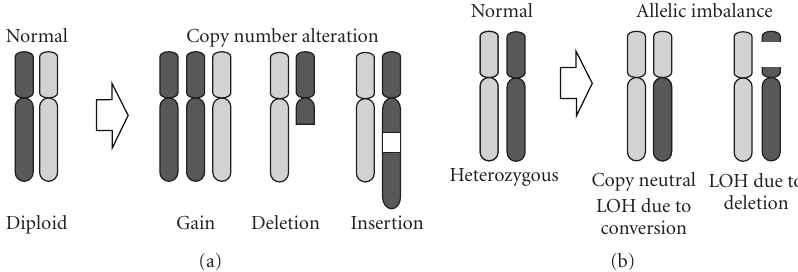
Figure 1: Mechanisms of DNA copy number alteration. (a) Segmental gains and losses can lead to DNA copy number alterations. (b) Allelic imbalance and loss of heterozygosity (LOH) can arise from a deletion event or gene conversion during mitosis.